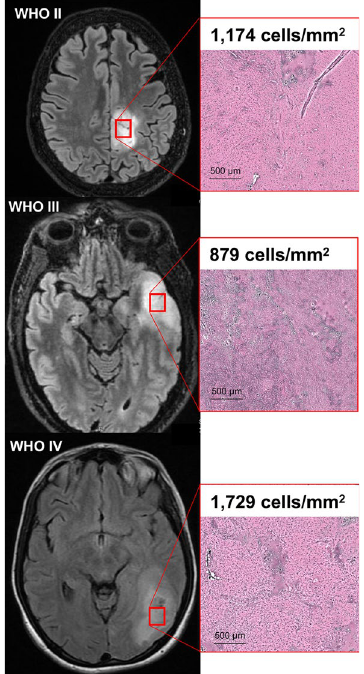
Figure 1. T2-weighted fluid attenuation inversion recovery (FLAIR) images of three participants with World Health Organization (WHO) grade II, III, and IV glioma (left). Red boxes indicate regions of FLAIR signal abnormality biopsied for pathologic examination and cell-counting with Raman scattering microscopy (right). Pseudo-H&E images of fresh biopsy specimens demonstrate ablation of normal cytoarchitecture across all WHO tumor grades. Here, lesion cellularity and necrotic features escalate with increasing WHO grade.